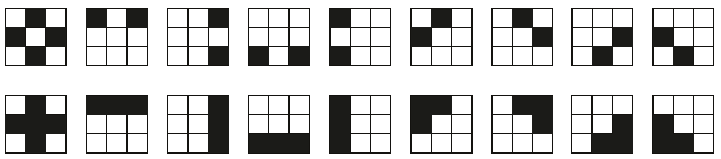
Figure 4: Bad human visual e ff ects caused by pattern substitution during the data embedding process.